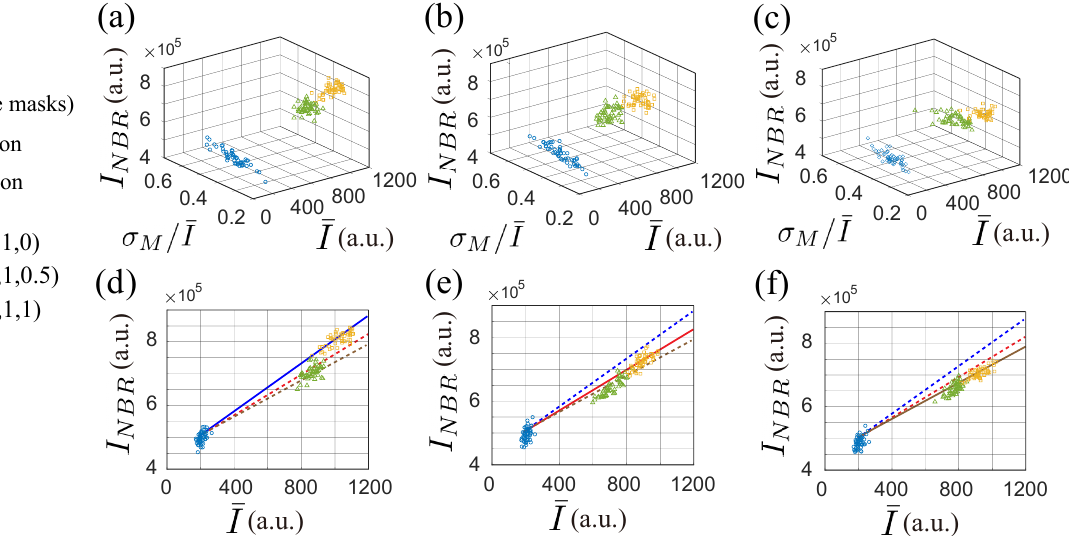
Figure 13. 3-D and 2-D plots of experimental population evolution of SBGA with three discriminants ( f 1 , f 2 , f 3 ) and three different sets of ranking coefficients ( a ) ( a , b , c ) = ( 2,1,0 ) , ( b ) ( a , b , c ) = ( 2,1,0.5 ) , and ( c ) ( a , b , c ) = ( 2,1,1 ) . The 2-D plots shown in ( d – f ) present the relation between average intensity ¯ I and neighboring intensity I NBR . In each 2-D plot, the solid line follows the average evolution trend and the dashed lines represent a comparison between different sets of ranking